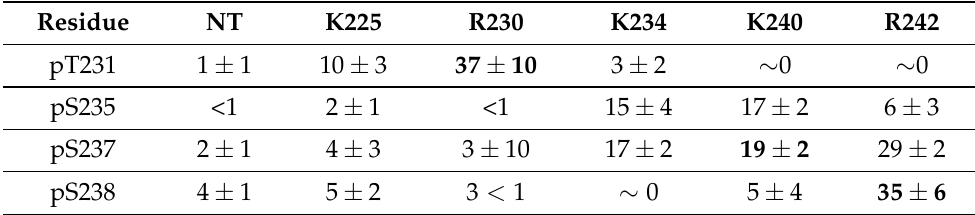
Table 3. Probability of salt bridge formation (%) between phosphorylated residues and positively charged residues in Tau2, where NT is the N-terminus. The data are obtained from Ref. [31]. The values printed in bold correspond to the experimentally established salt bridges